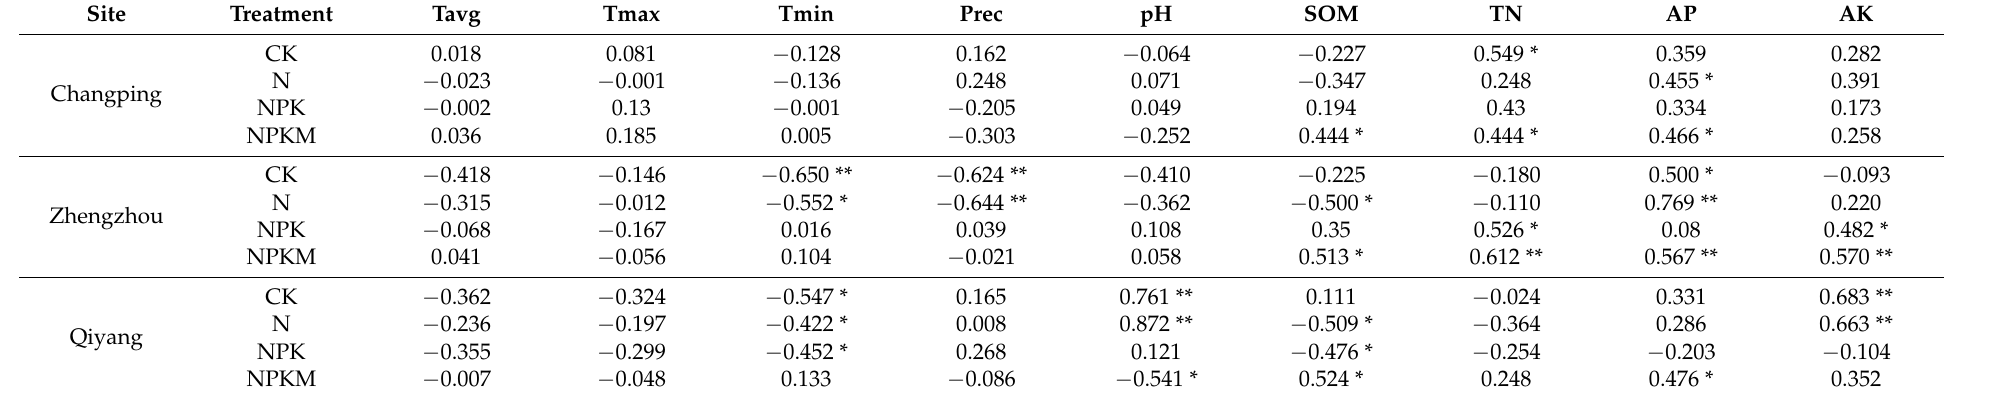
Table 4. The correlation coefficients between maize yields and main climatic and soil fertility factors in the three experimental sites.